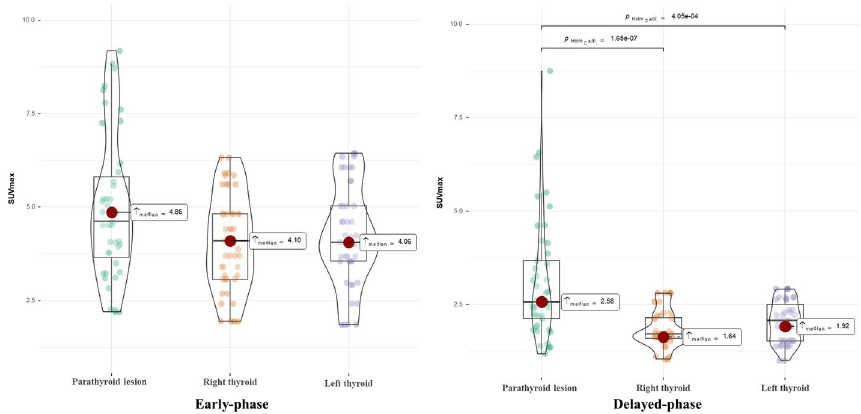
Fig. 1 SUVmax values of parathyroid lesions and both thyroid lobes in early-phase and in delayed-phase images. Median SUVmax of parathyroid lesions in early phase was 4.86, which was higher than both thyroid lobes without significant differences. Median SUVmax of parathyroid lesions in delayed phase was 2.58, which was higher than in both thyroid lobes, the differences being statistically significant (both P < 0.001)